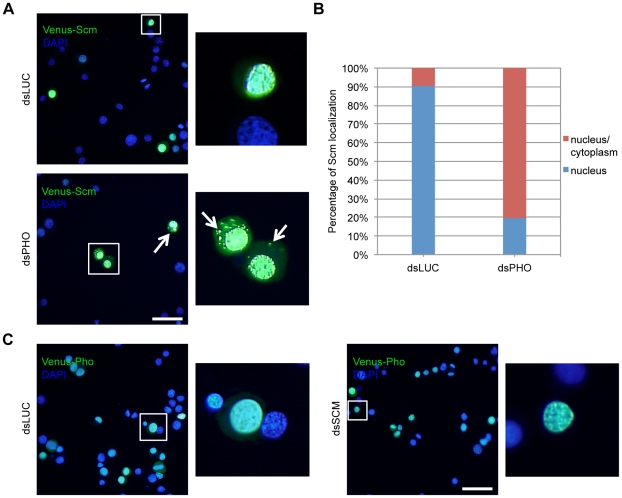
Knockdown of BmPHO partially affected the localization of BmScm.(A)Down-regulation of BmPHO greatly increased the localization of BmScm in the cytoplasm. The BmN4-SID1 cells were pre-cultured with dsRNA specific for BmPHO or dsRNA against LUC for 3 days, and then were transfected with Venus-fused BmScm for another 3 days. The cells were imaged by microscope and the nuclei DNA was counterstained with DAPI. The fluorescence signals localized in the cytoplasm were indicated with arrows. Scale bar: 50 µm. (B) The cell numbers of variant distributions indicated in (A) was counted under microscope from various fields, and the percentage of each fraction was shown in the graph. N = 96 for dsLUC treatment, and N = 77 for dsPHO treatment. (C) Down-regulation of BmSCM did not change the localization of BmPho. Scale bar: 50 µm.